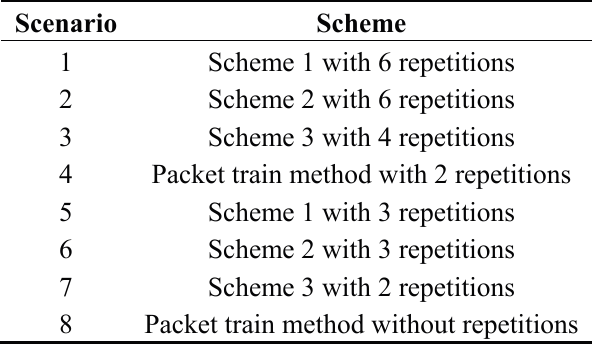
Table 3. Simulation